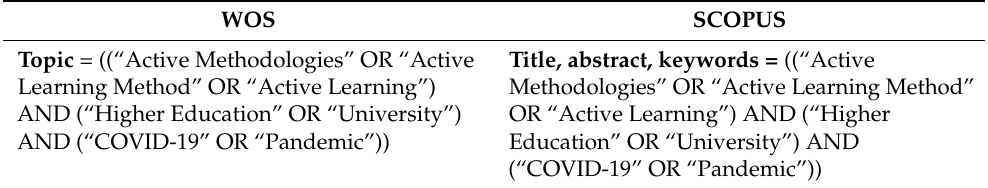
Table 1. Search descriptors.